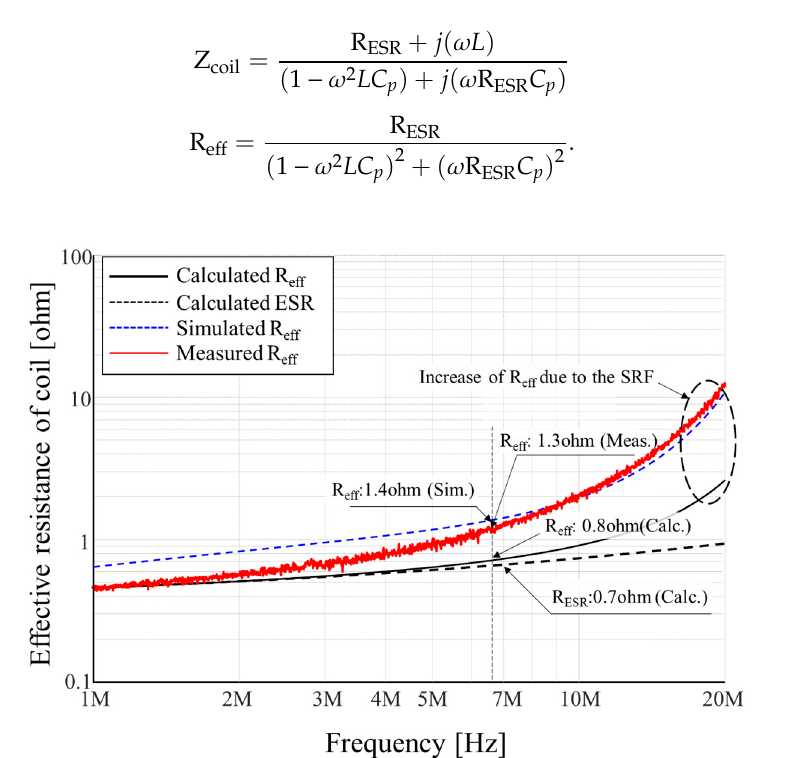
Figure 3. E ff ective resistance of coil. The R ESR of coil is determines the e ff ective resistance of coil below Figure 3. Effective resistance of coil. The R ESR of coil is determines the effective resistance of coil below the self-resonance the self-resonance frequency.